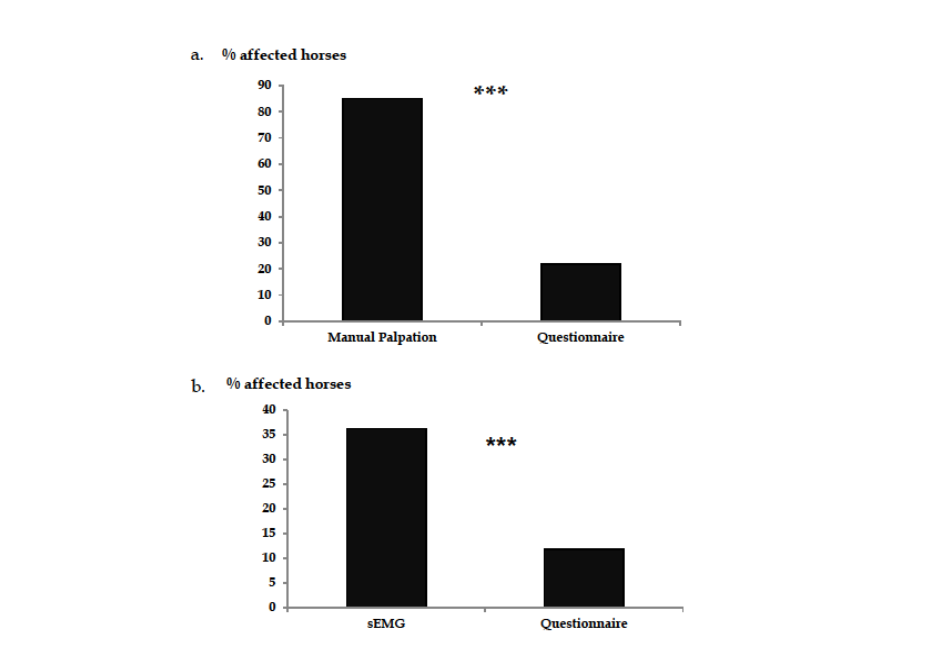
Figure 3. Evaluation of back problems through clinical evaluations and questionnaires. Note the similar discrepancies with questionnaires in both types of clinical evaluation. Chi square test, *** p < 0.001. a. Percentage of horses considered as affected via manual palpation on the left and questionnaire evaluation on the right. b. Percentage of horses considered as affected via sEMG on the left and questionnaire evaluations on the right. From Lesimple et al. (2013), BMV Veterinary Research